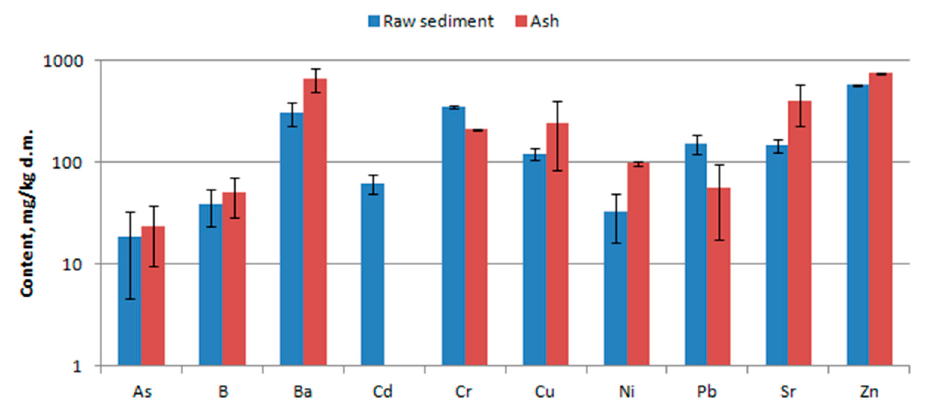
Figure 4. Heavy metals content in PETWW before and after combustion with marked error bars.